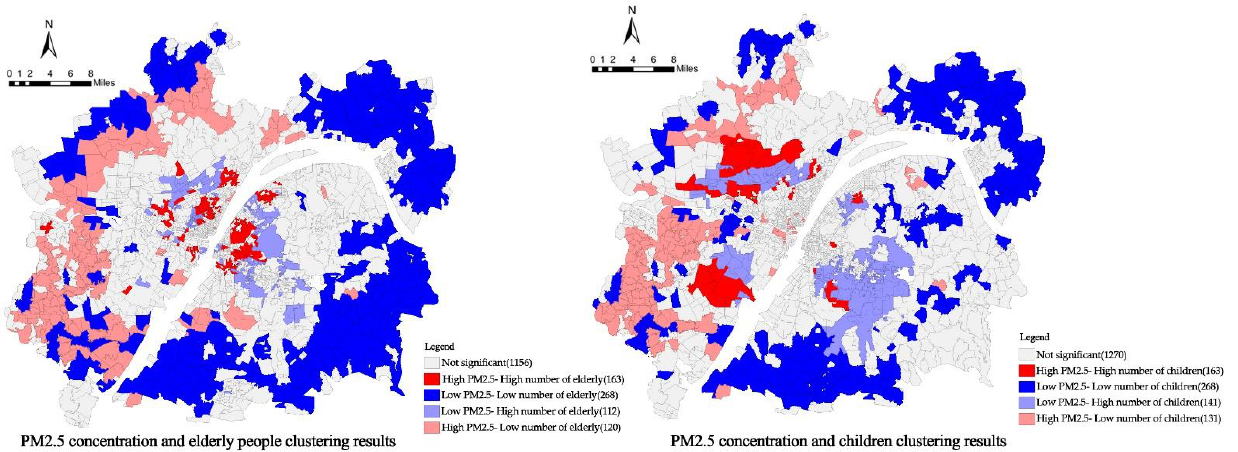
Figure 11. PM 2.5 concentration and elderly people clustering results, PM 2.5 concentration and children clustering results.